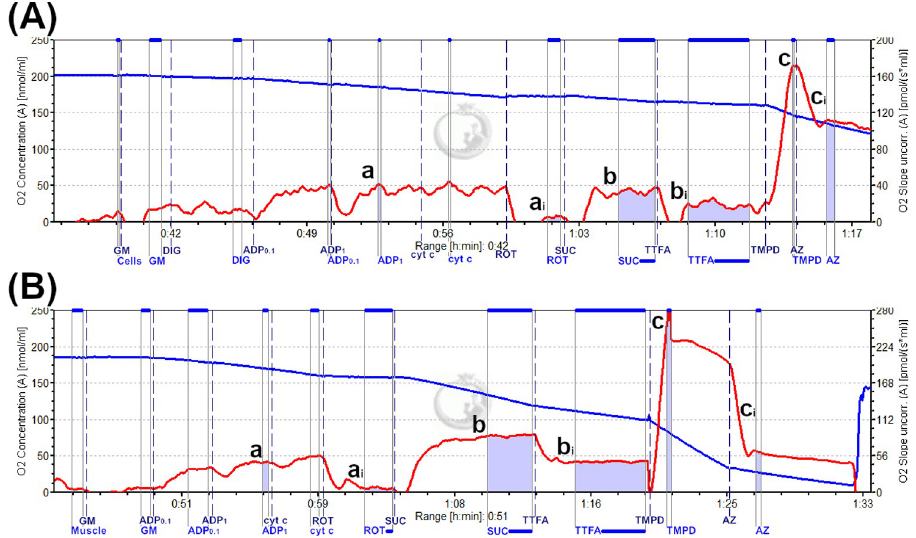
Fig 1. Representative bioenergetic profile for peripheral blood mononuclear cells and permeabilized skeletal muscle fibers from one individual. The rate of oxidative phosphorylation for PBMCs (A) and permeabilized skeletal muscle fiber (B) was measured in a high-resolution respirometer OROBOROS Oxygraph-2k. The blue line represents oxygen concentration in the oxygen chamber, and the red line represents the rate of oxygen consumption. 5.2 mg of skeletal muscle and 5.8 x 10 6 cells are represented in (A) and (B), respectively. Boxed blue lines indicate recorded data points. Glutamate + malate (GM) + 1mM ADP (ADP 1 ), succinate, and tetramethyl- p -phenylenediamine + ascorbate (TMPD) were substrates used for complex I (a) , II (b) , and IV (c) substrates, respectively. Rotenone (ROT), thenoyltrifluoroacetone (TTFA), azide (AZ) were used to inhibit complex I (a i ) , II (b i ) , and IV (c i ) ,